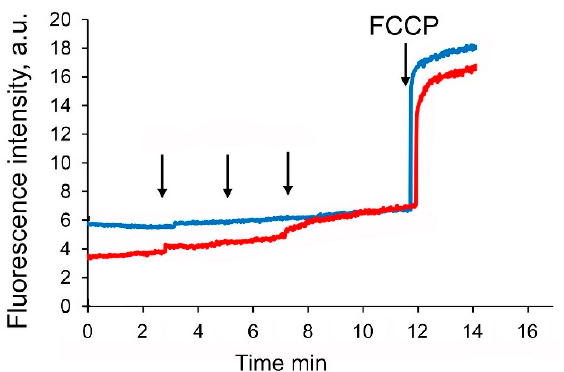
Figure 7. Effects of F16-betulin conjugate on mitochondrial membrane potential. Additions: 5 µ M of F16-betulin (shown by an arrow) in the presence of glutamate plus malate ( red line ) and succinate plus rotenone ( blue line ). 1 µ M carbonyl cyanide-p-trifluoromethoxyphenylhydrazone (FCCP) added at the end of the recordings to completely depolarize the inner mitochondrial membrane. A similar pattern was observed in three independent experiments.